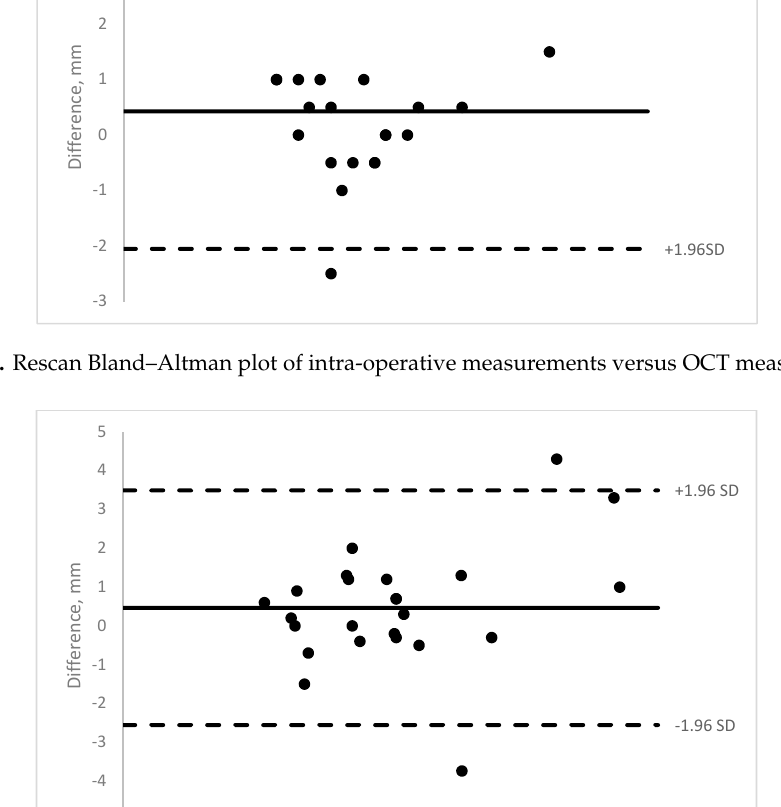
Figure 5. Spectralis Bland–Altman plot of intra-operative measurements versus OCT measurement. J. Clin. Med. 2019 , 8 , x FOR PEER REVIEW